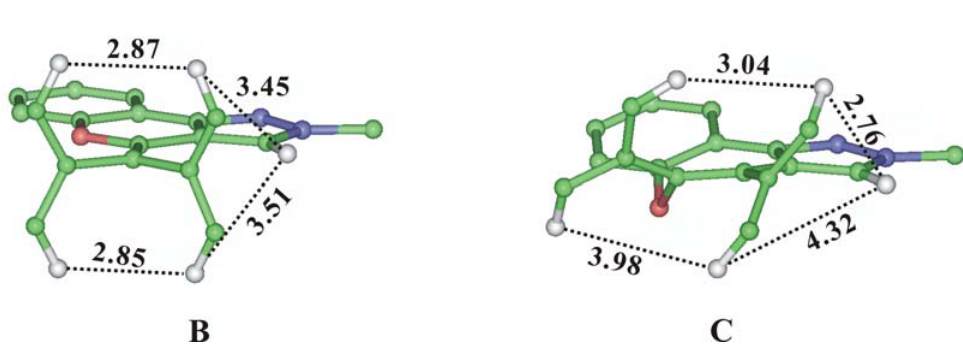
Figure 3. Energy Minimized Structure and Specific Proton Distances of Compound B and C (some heavy atoms and hydrogens were removed from the view for